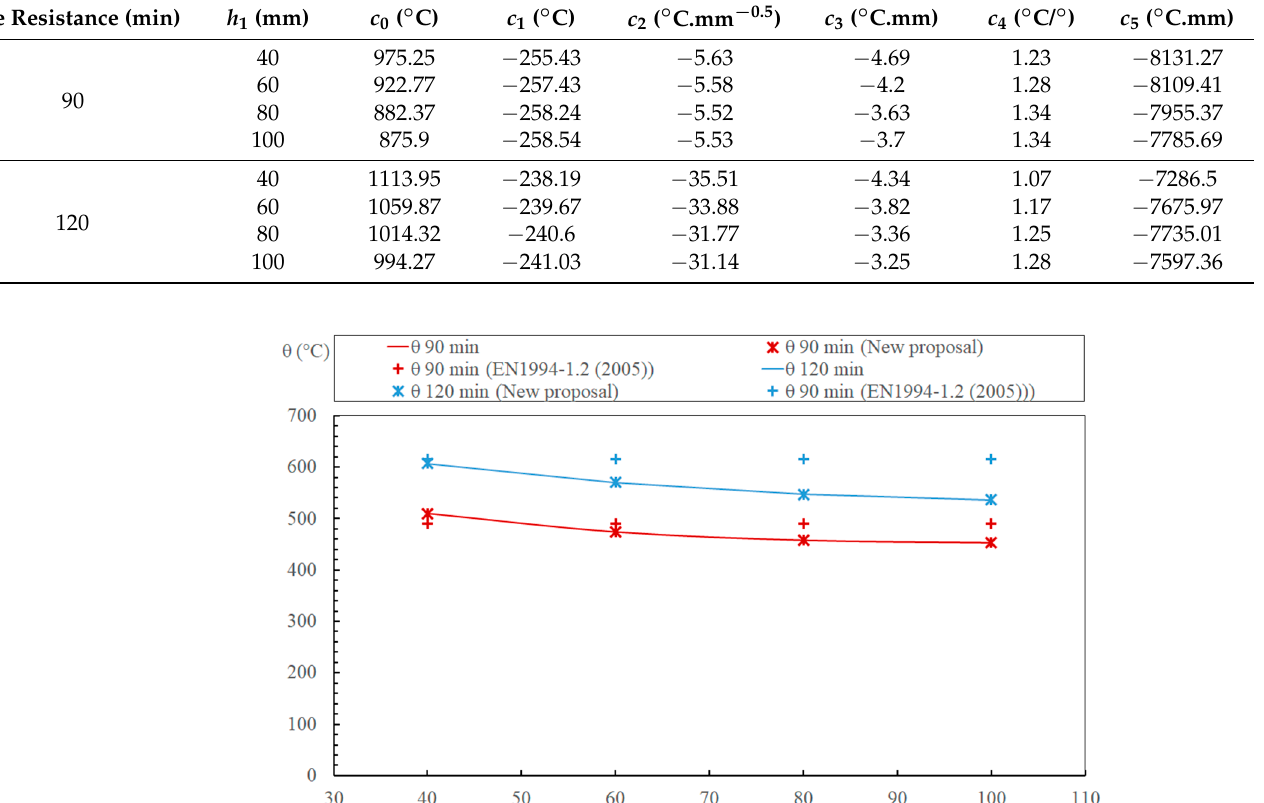
( d ) Figure 11. Temperature profile during the cooling phase of the composite slab Multideck 50 for different values of h 1 : ( a ) h 1 = 40 mm; ( b ) h 1 = 60 mm; ( c ) h 1 = 80 mm; ( d ) h 1 = 100 mm. 4. Discussion According to the data presented in Section 3, this section will discuss the reliability of the numerical model by comparing the experimental and the numerical results, as well as the reliability and application of the new proposal.